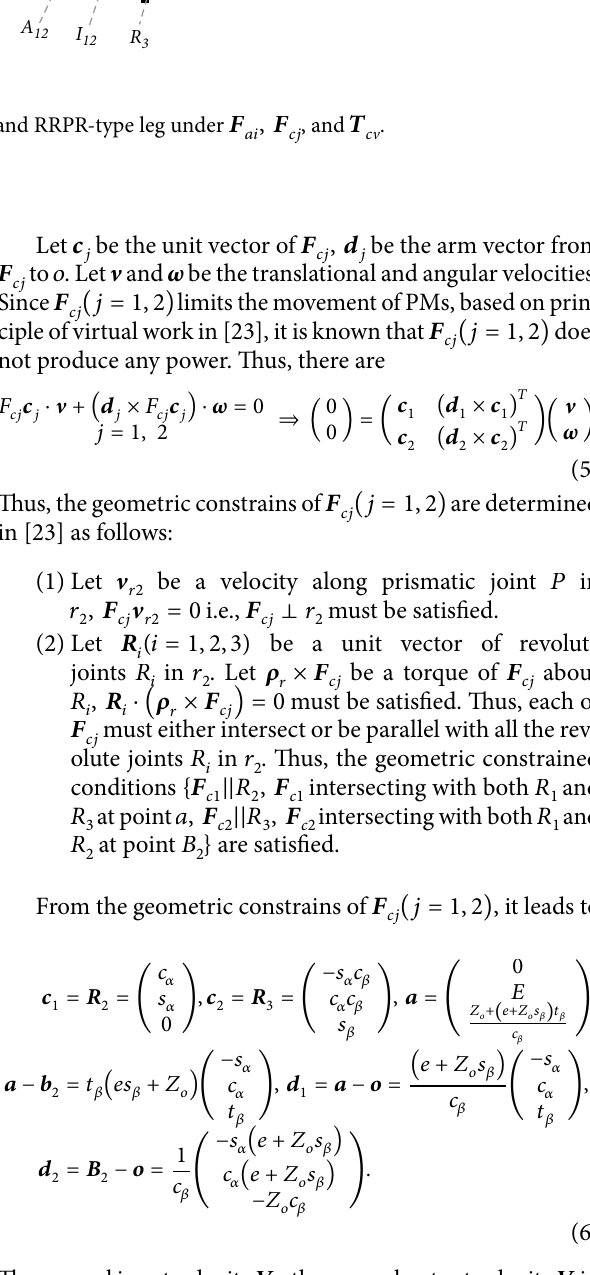
Figure 3: Elastic deformations of SPS-type legs and RRPR-type leg under 𝐹